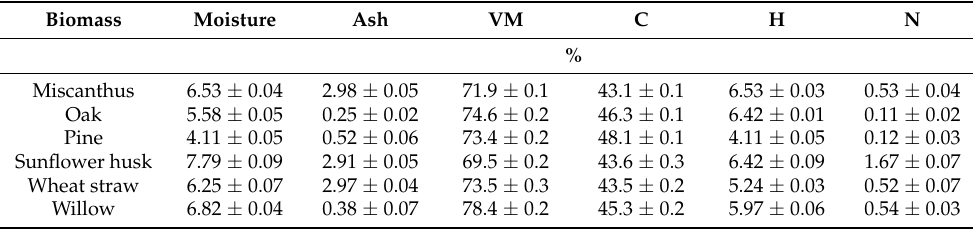
Table 1. Characteristics of the pellets used in the research. Biomass Moisture Ash